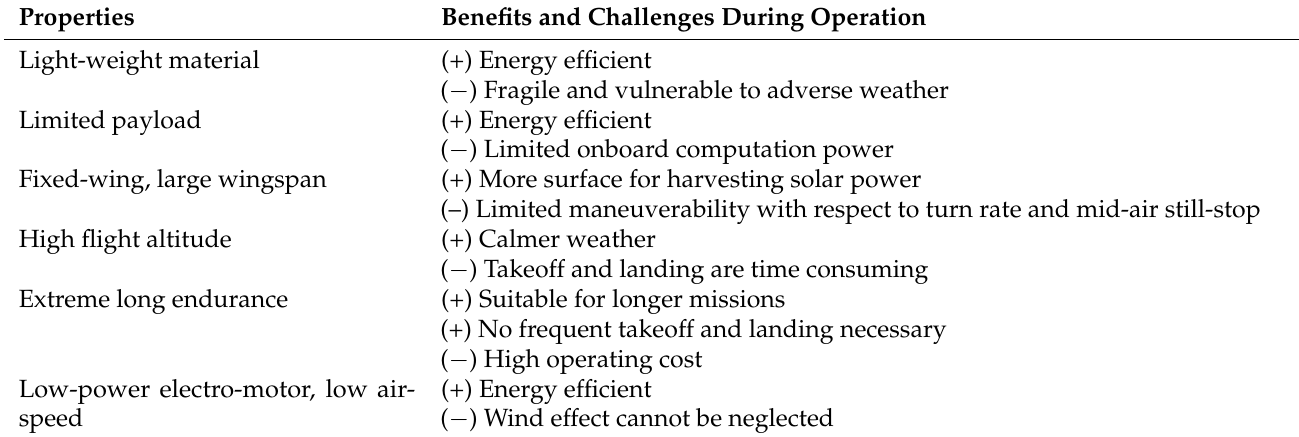
Table 1. Relationships among characteristics of HAPSs and their benefits (+) and challenges ( − ). Properties Benefits and Challenges During